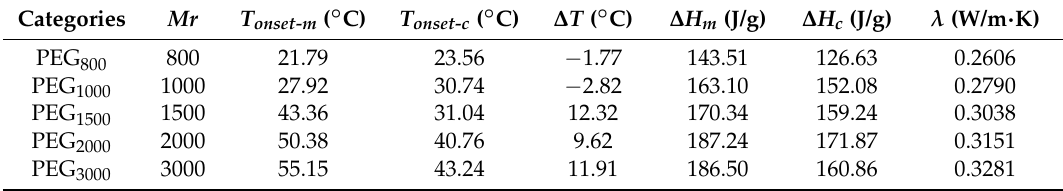
Table 1. Basic properties of the polyethylene glycols (PEGs) used in this research.